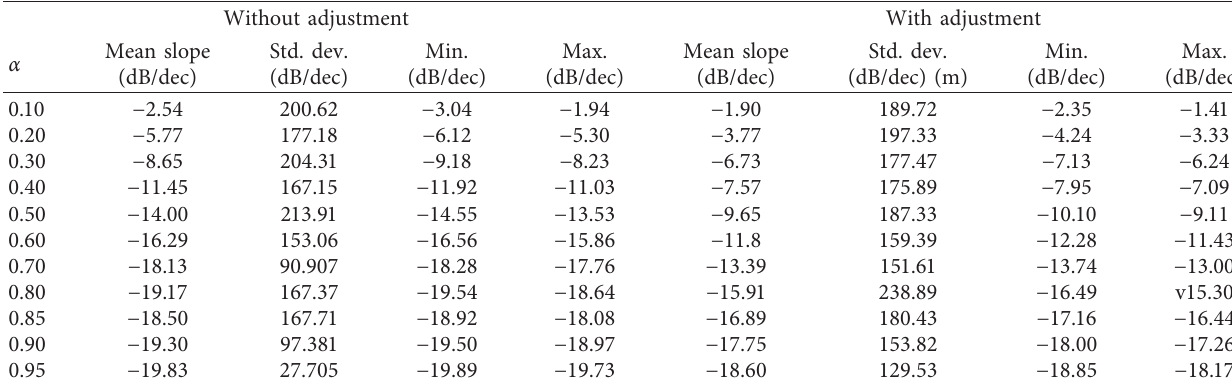
Figure 6: Histograms (Monte Carlo analysis): (a) α � 0 . 9 and (b) α � 0 . 95. Table 2: Monte Carlo